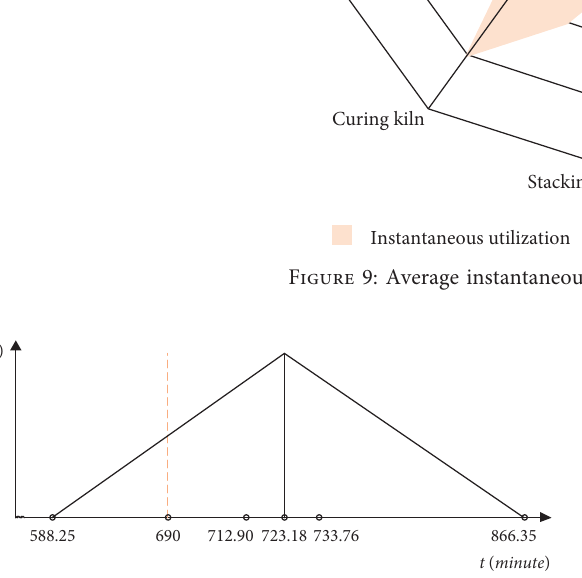
Figure 10: Comparison of simulation results with expected pro- duction